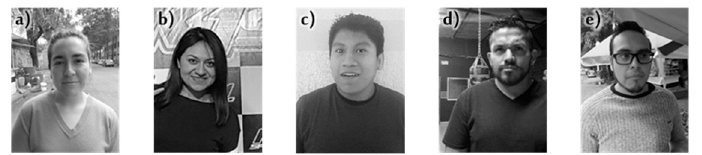
Figure 8. Examples of frames of the Face-MECS database, ( a ) neutral, ( b ) happiness, ( c ) surprise, ( d ) anger, ( e ) sadness.